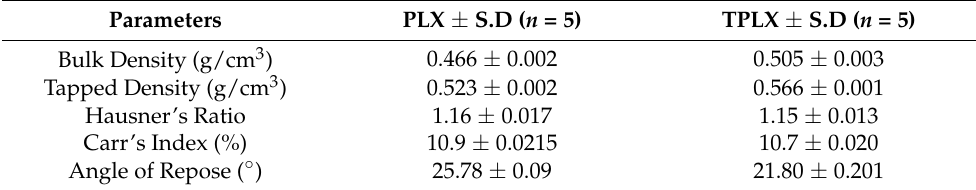
Table 3. Micromeritics analysis of PLX and